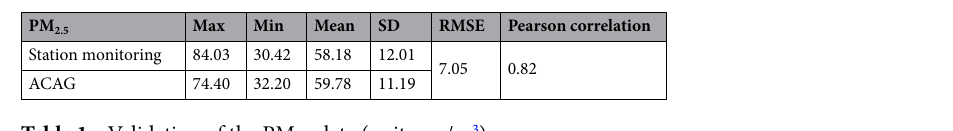
Table 1. Validation of the PM 2.5 data (units: μg/m 3